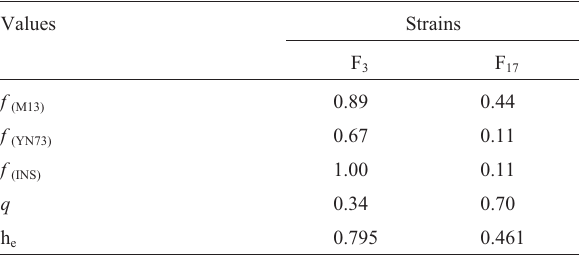
Table II - Frequency of polymorphic loci ( f ), allele frequency ( q ) and mean heterozygosity